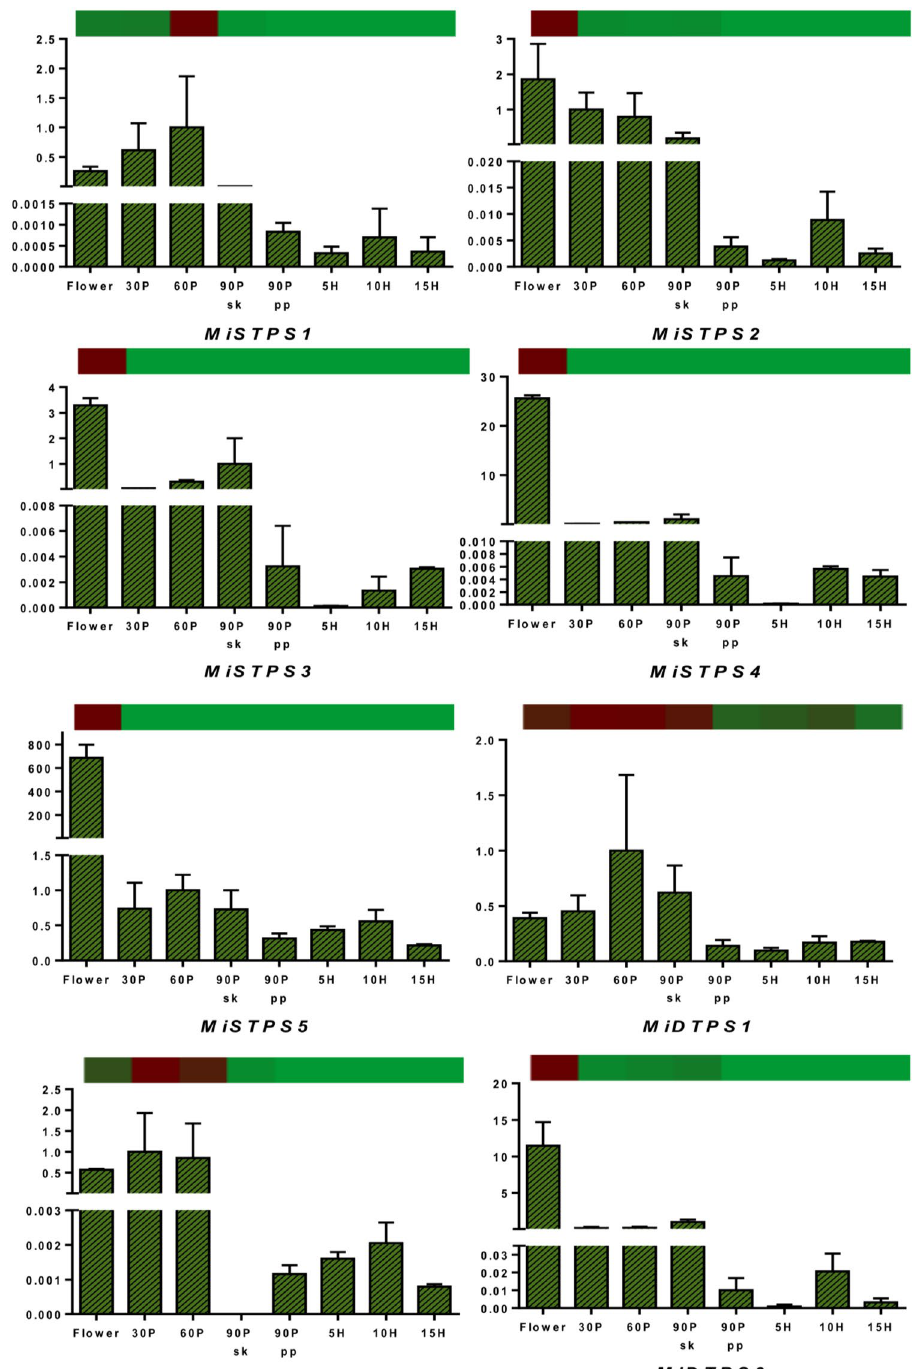
Figure 9. Quantitative reverse-transcriptase PCR validation of various transcripts obtained through RNAseq from sesqui-terpene and di-terpene metabolism through various tissues (flower and fruit developing and ripening stages). Vertical bars at each data point represent standard error in the relative quantification among the three biological replicates. X-axis represents fruit development and ripening stages and Y-axis represents relative transcript abundance. The horizontal bar above each histogram represents the expression level of the same transcript as obtained through RNAseq analysis, wherein dark-red color indicates higher expression and light-green color indicates lower expression. Gene names are as referred in result section “Transcriptome validation through qRT